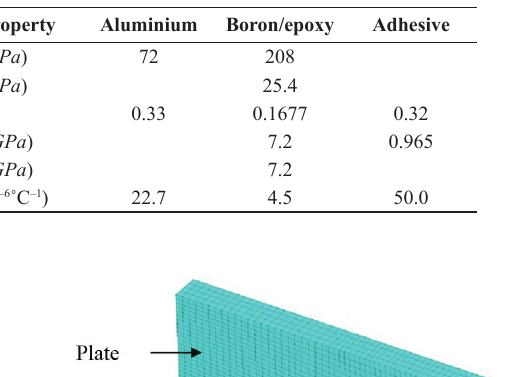
Table 1. Materials properties (plate, patch and adhesive).